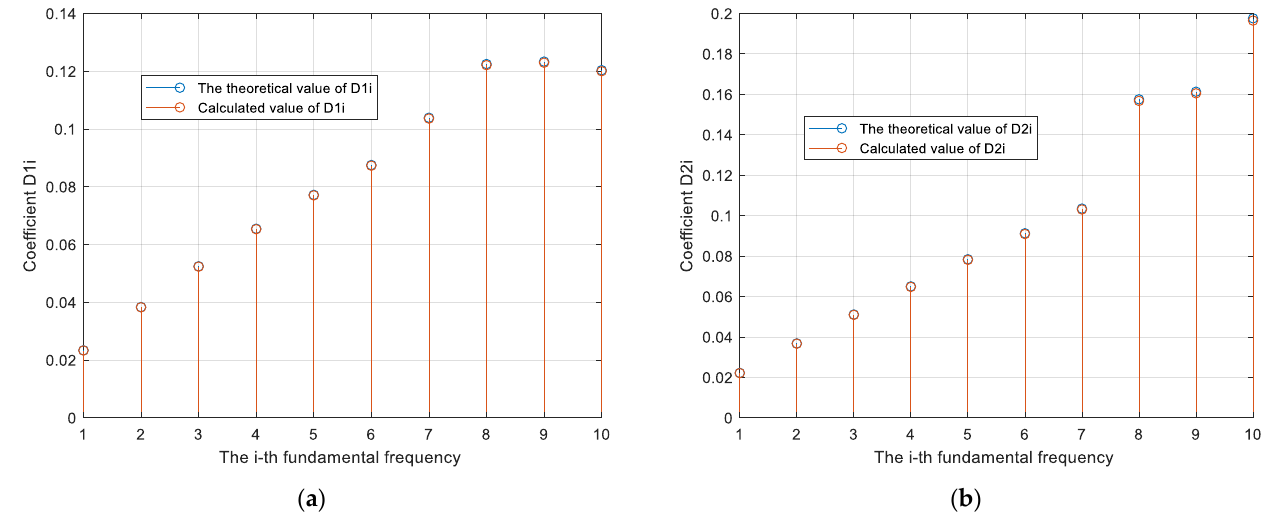
Figure 3. ( a ) The theoretical value and calculated value of D 11 i ; ( b ) the theoretical value and calculated value of D 21 i .